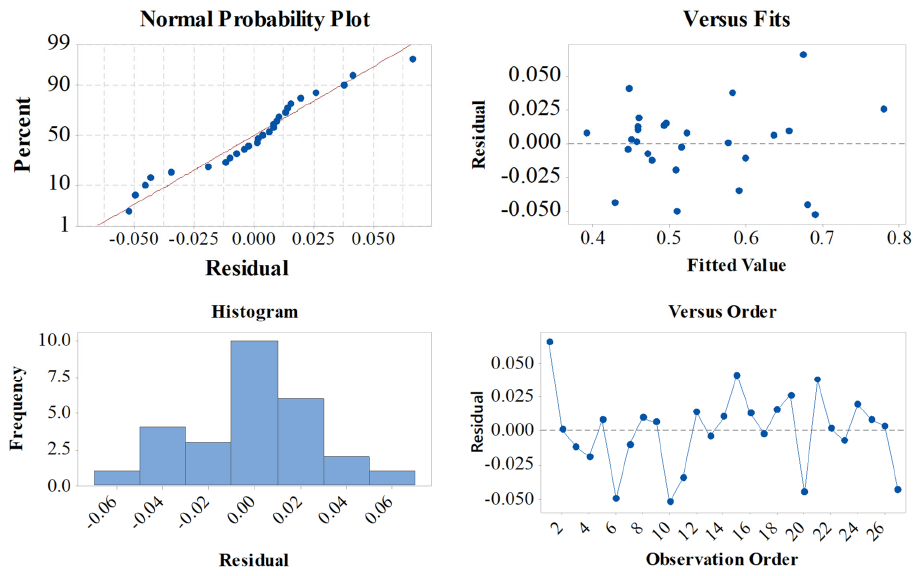
Figure 5. Residual plot for GRG.